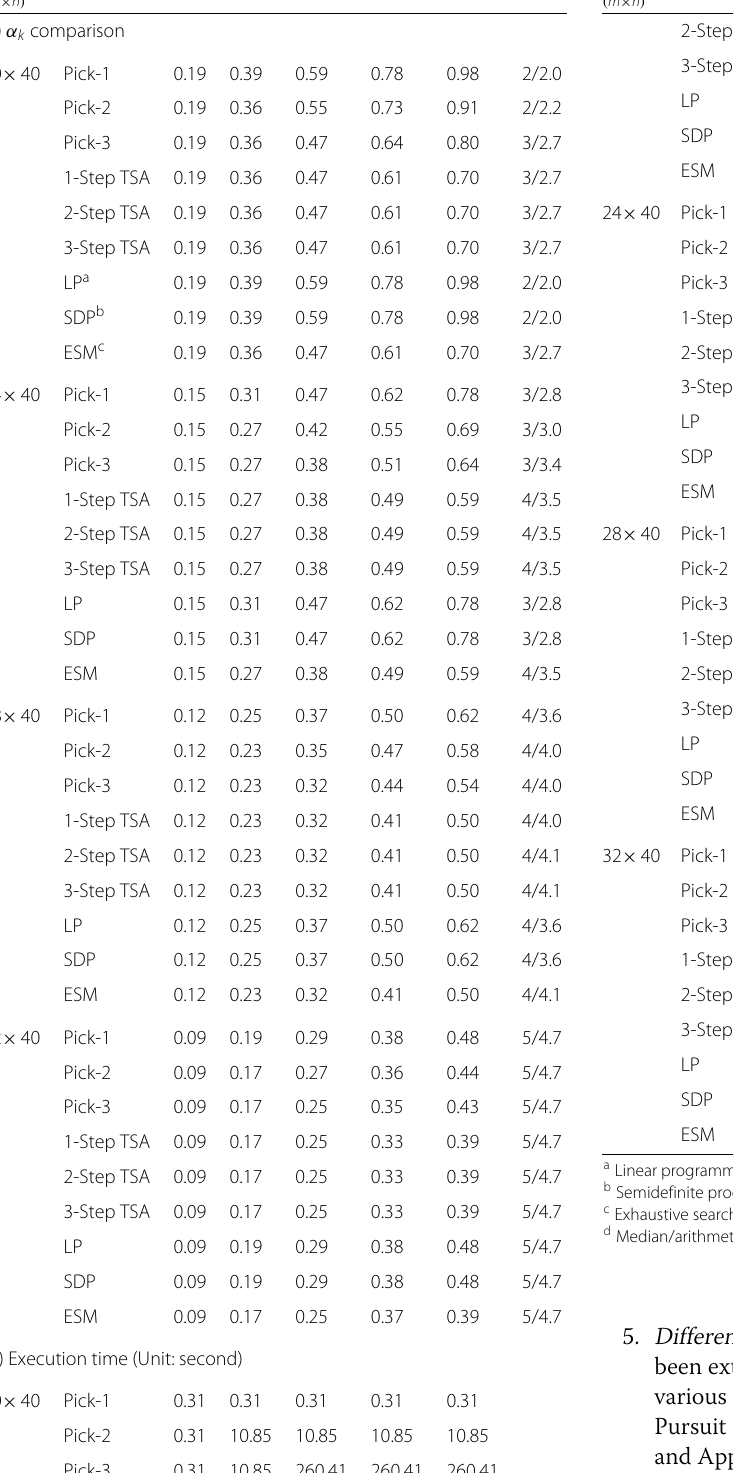
Table 8 α k comparison and execution time - Partial Fourier Matrix ( Continued